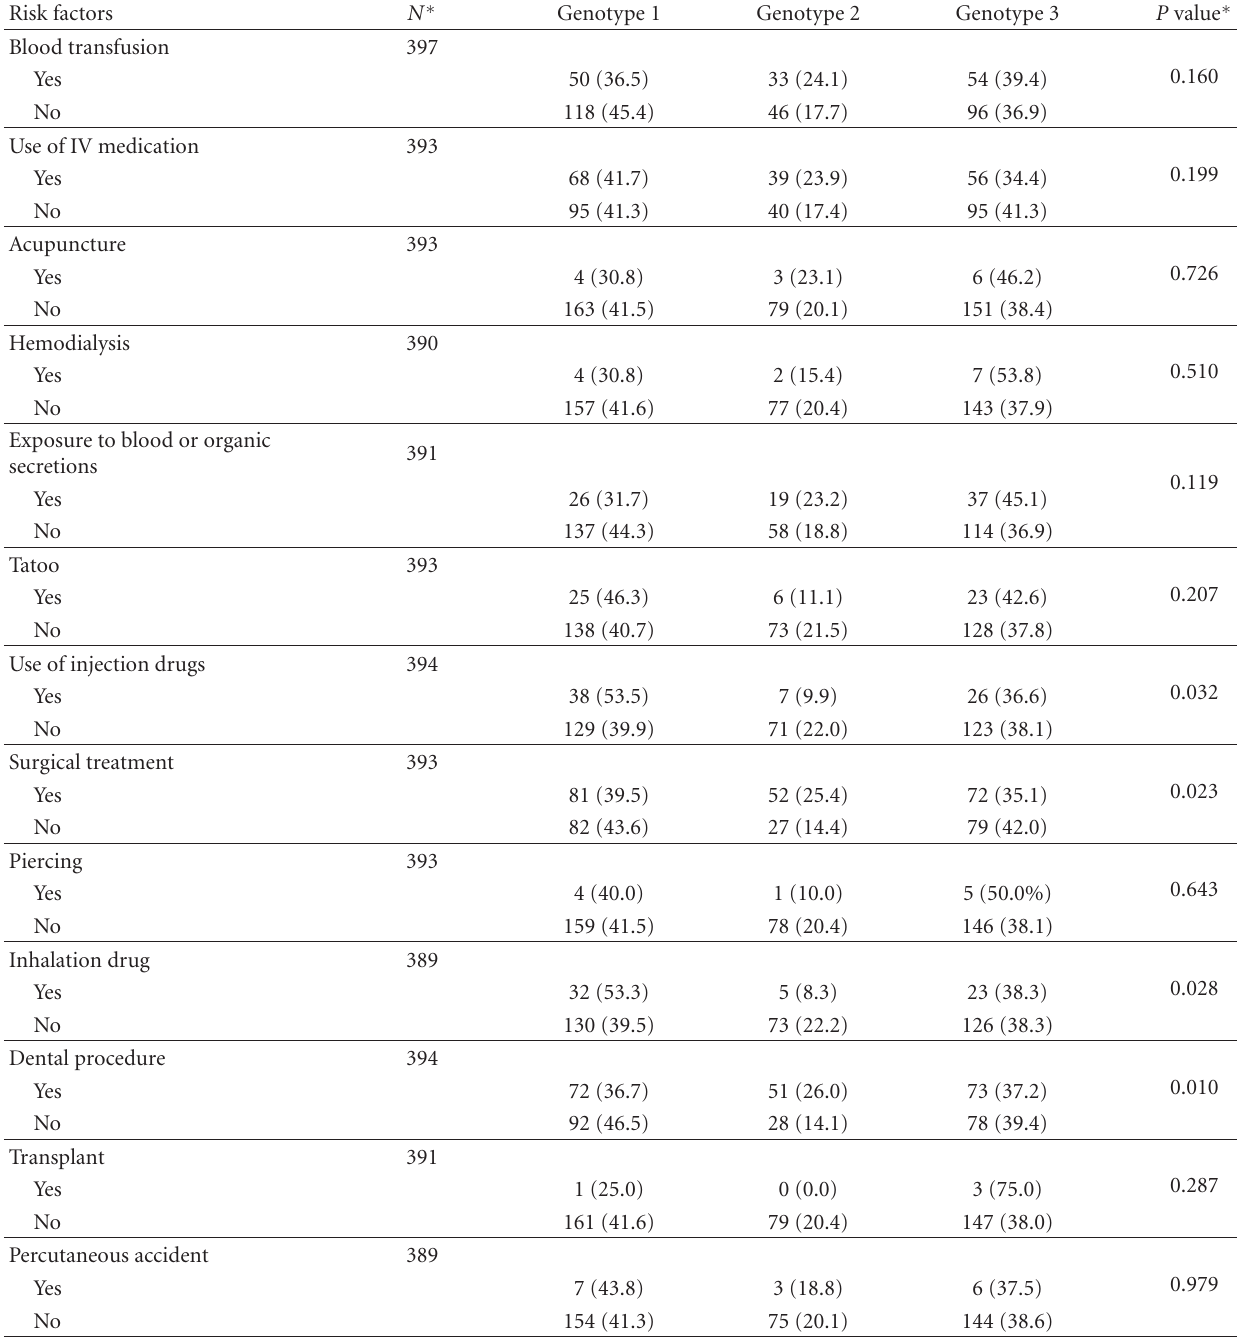
Table 2: Genotype distribution according to risk factors among hepatitis C virus-infected patients from the countryside of southern Brazil ( N and